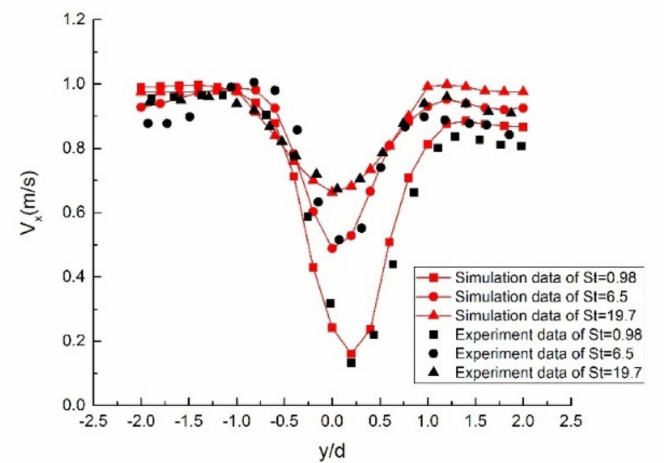
Figure 3. The streamwise velocity distributions of air in the wake of a circular cylinder at three Stokes numbers.